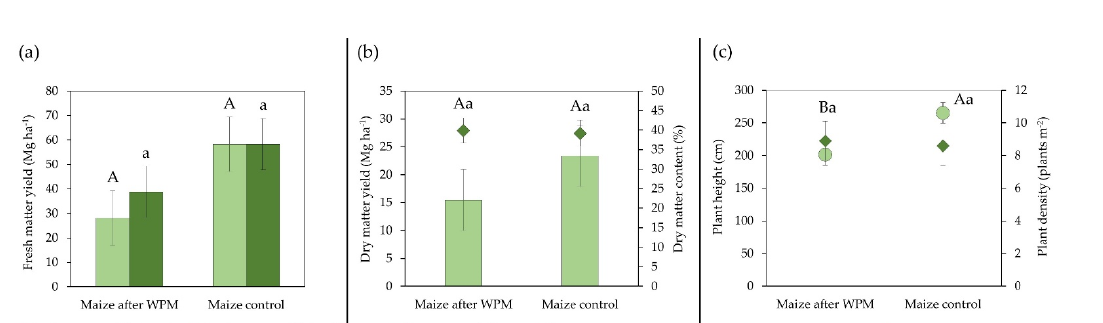
Figure 6. The results of the statistical analyses (estimates and standard errors) of the fresh matter yield components ( a ), total dry matter yield and dry matter content ( b ) and plant height and plant density ( c ) of the maize at harvest on 14 September 2021. “Maize after WPM” denotes the area where wild plant mixtures (WPMs) were grown during the years of 2013 to 2018. “Maize control” denotes the area that was cultivated with grassland (four-cut regime). Upper case letters denote significant ( p < 0.05) differences between the treatments of fresh matter yield (maize) ( a ), total dry matter yield ( b ) and plant height ( c ). Lower case letters denote the other respective parameters shown in ( a – c ). Table 1. An overview of the morphological parameters of maize, common tansy and the total bio- mass per treatment. For each observation, the raw data, average values and standard deviations are shown.